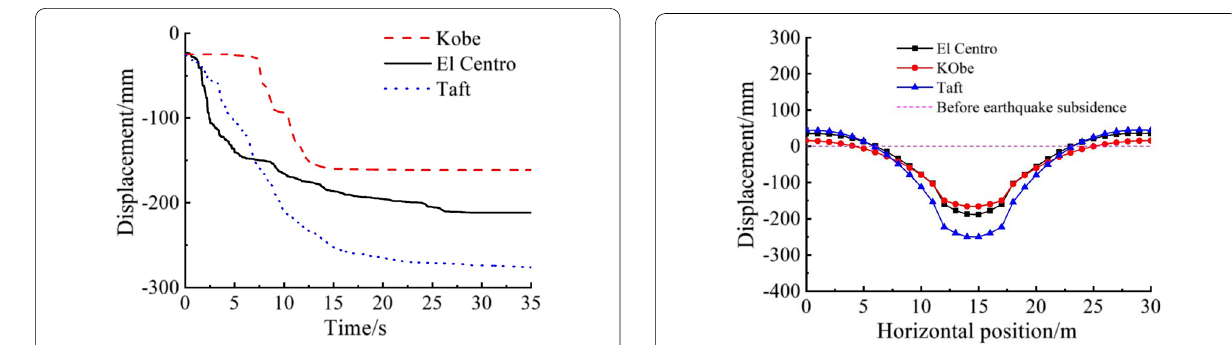
Fig. 19 Time history curve illustrating the vertical subsidence of soil due to different ground motions